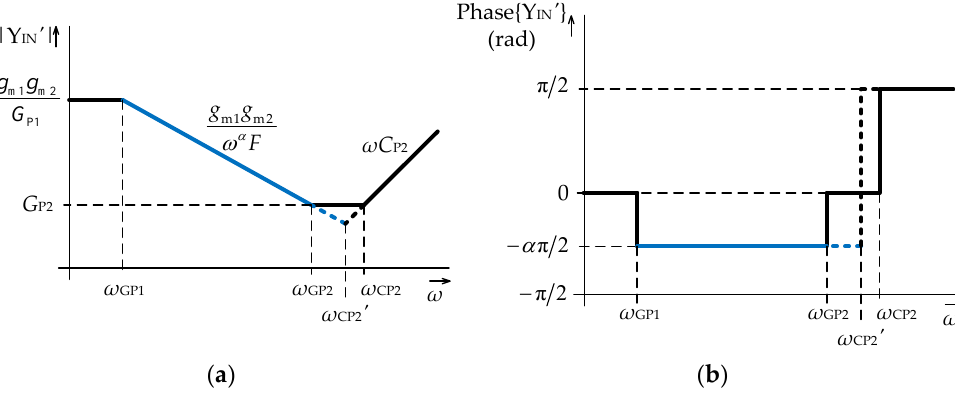
Figure 5. Bode plots of ( a ) magnitude and ( b ) phase admittance characteristics according to (7). Blue parts denote ideal function without the influence of parasitics.